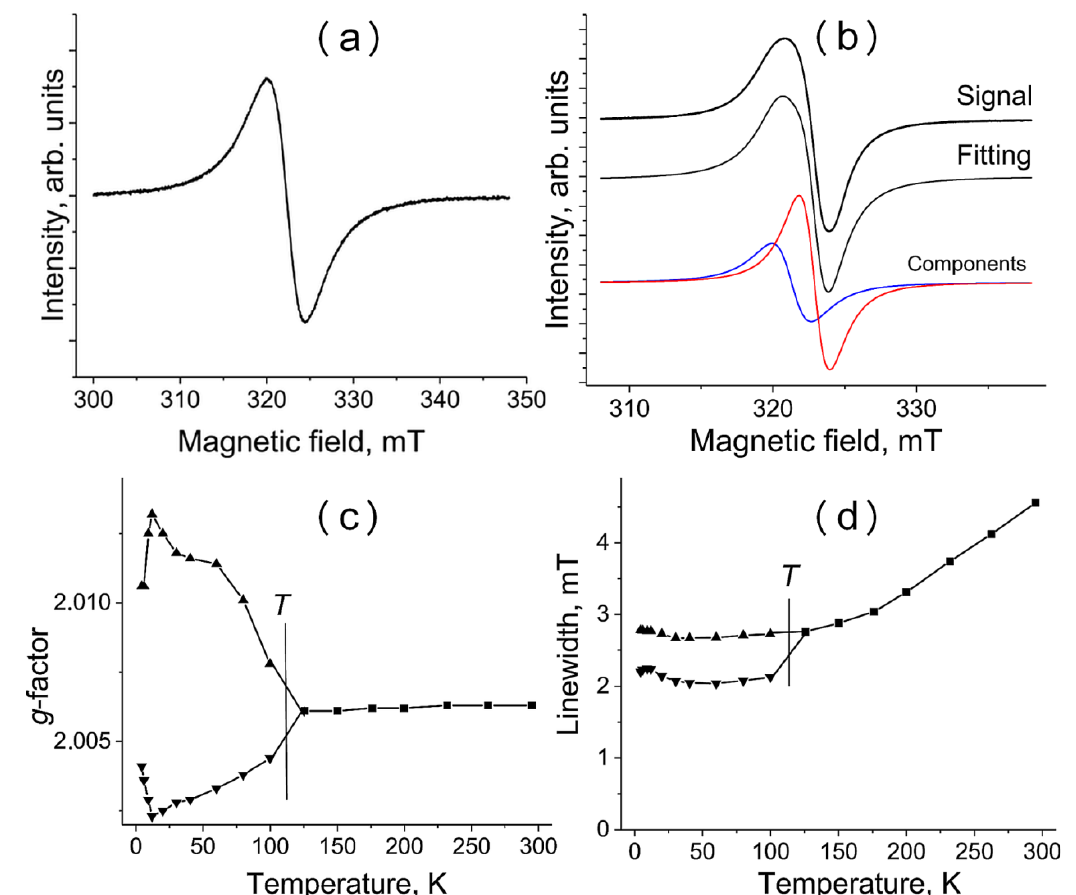
Figure 7. ( a , b ) EPR signal from 1 at 295 K and 20 K. An approximation of the signal by two Lorentz lines at 12 K is shown at the bottom of the figure. ( c , d ) Temperature dependencies of EPR signal parameters for 1 : ( c ) g -factor and ( d ) linewidth. “ T ” denotes the temperature of splitting of the EPR signal into two Lorentz lines.